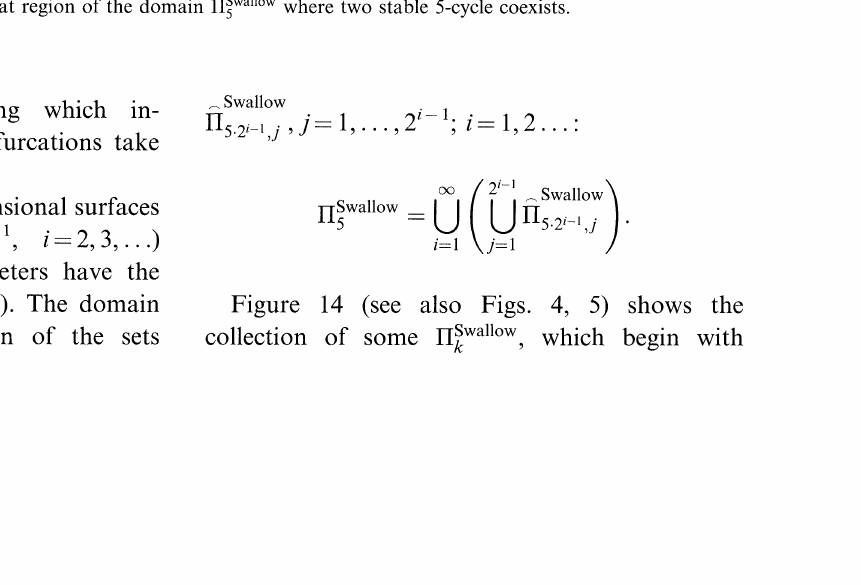
FIGURE 15 (a) Bifurcation diagram for c=1.53 and 0.14_</3<0.165 and (b) branching pattern for c=1.53 and 0.145 _</3 _< 0.162. This section intersects that region of the domain 1-I5 Swallw where two stable 5-cycle